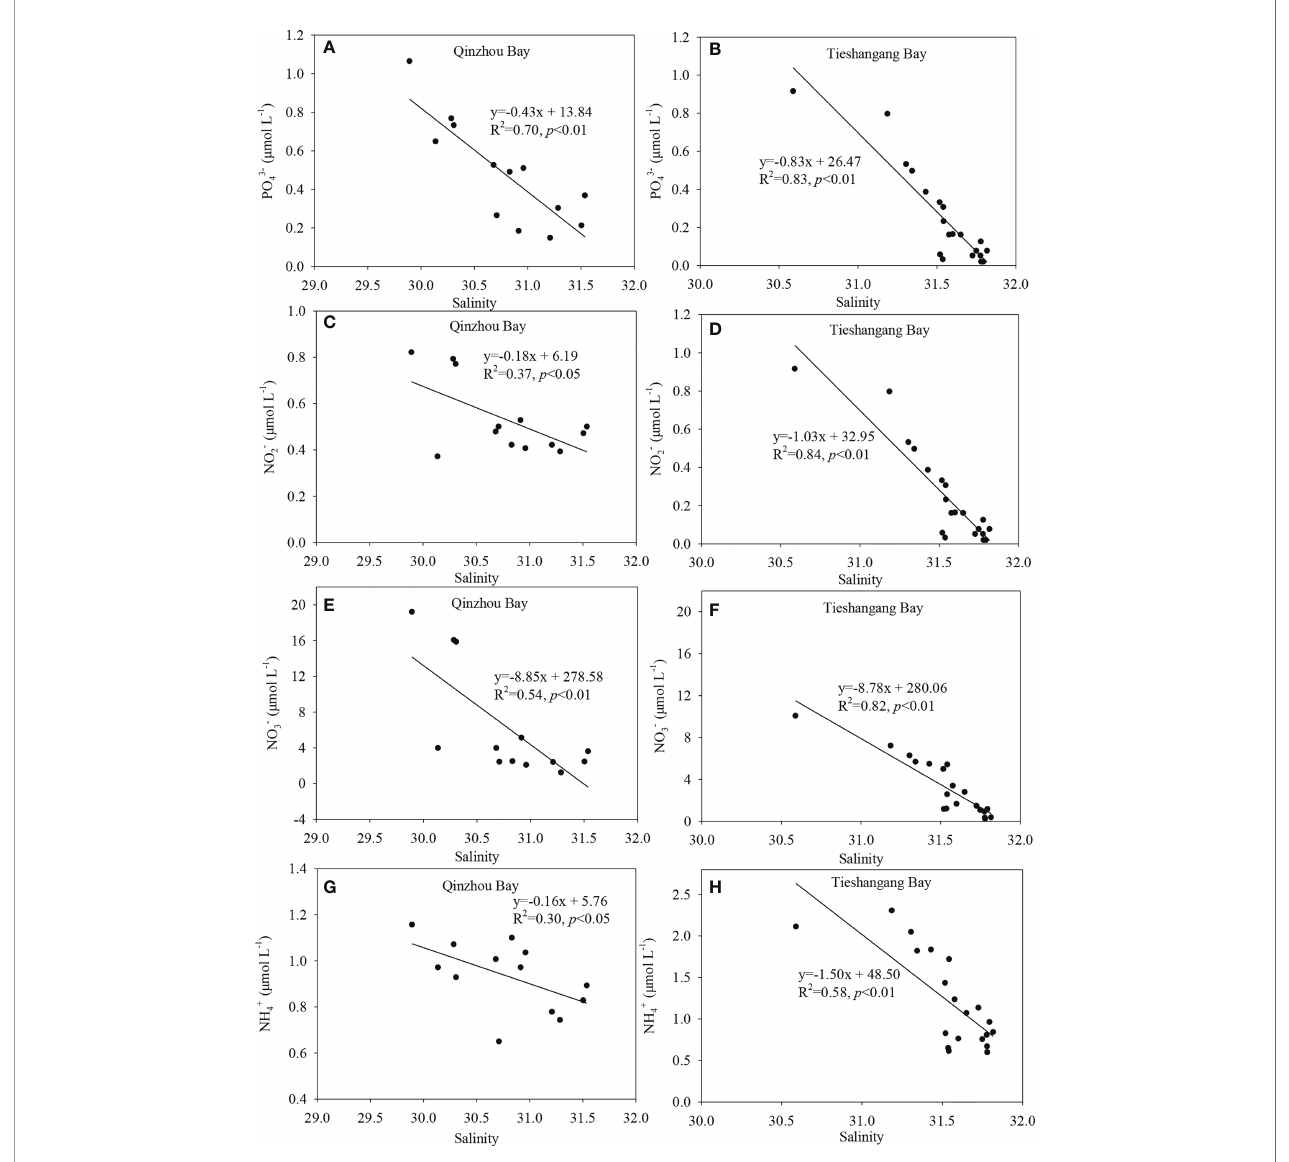
FIGURE 6 | Linear relationship between nutrient ½ PO 3 − 4 (A, B), NO − 2 (C, D), NO − 3 (E, F), and NH + 4 (G, H) ] and salinity in the Qinzhou Bay and Tieshangang